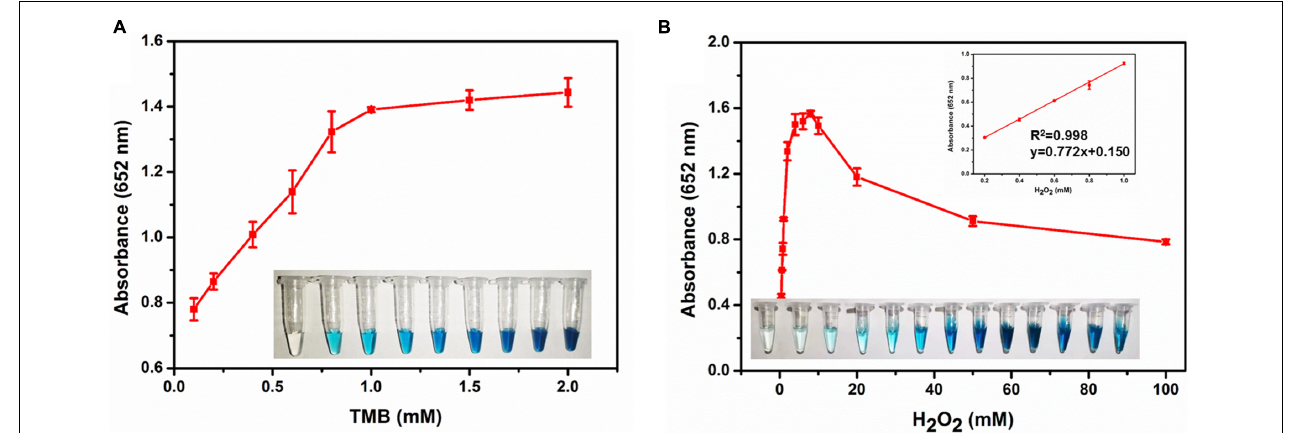
FIGURE 2 | (A) The absorbance at 652 nm in different concentrations of TMB. Inset represents the corresponding colorimetric result of the reactions. (B) The absorbance at 652 nm in different concentrations of H 2 O 2 . Inset represents the corresponding colorimetric result of the reactions and the linear calibration plot for H 2 O 2 .